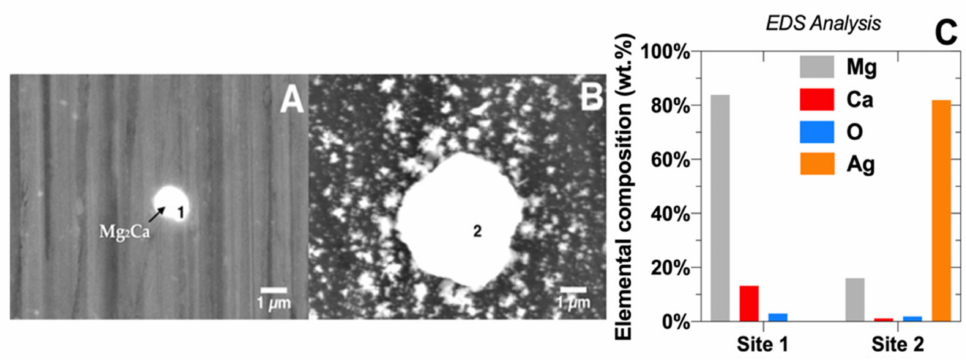
Figure 11. SEM images (10,000 × ) of Mg-Ca0.3 surface: ( A ) before and ( B ) after electroless deposited Ag-NPs and agglomerates by 10 − 3 M AgNO 3 (t = 3 min, at 21 ◦ C) and ( C ) EDS analysis on marked